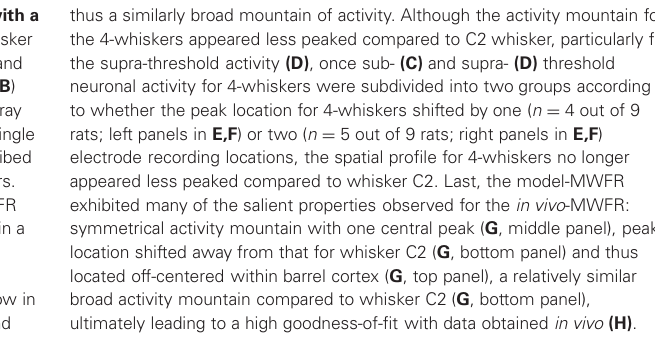
FIGURE 6 | Subset of 4 whiskers also evokes an activity mountain with a single central peak that can be predicted by modeling. The multi-whisker functional representation (MWFR) for the 4-whiskers array (D3, D4, E3, and E4) was assessed in vivo using intrinsic signal optical imaging ( n = 7; A–B ) and supra- and sub-threshold neuronal recordings from an 8-electrode array ( n = 9; C–F ), and compared to modeling based on linear summation of single whisker functional representations (G–H) . Details are the same as described in Figures 3 – 4 except the MWFR is for 4-whiskers instead of 24-whiskers. Note for both imaging (A,B) and neuronal recording (C,D) data, the MWFR for the 4-whiskers array consisted of a single peak located centrally within